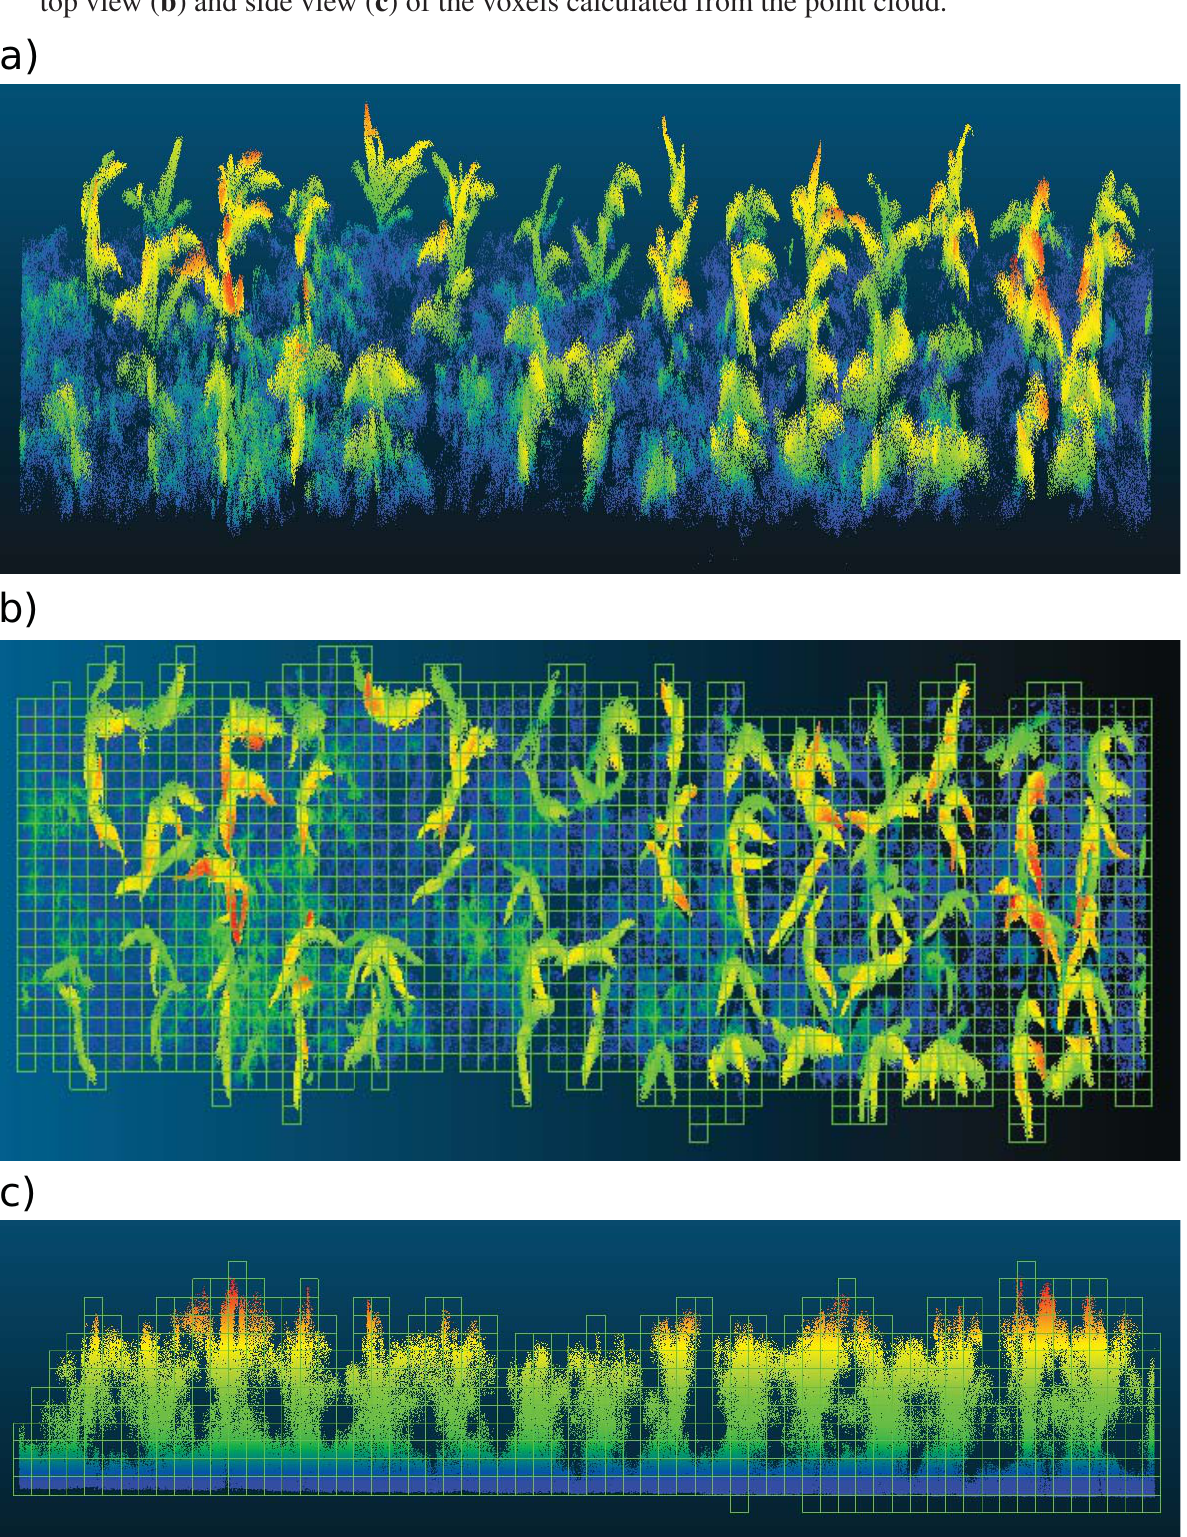
Figure 7. Point cloud calculated from the LiDAR. ( a ) Perspective view of the point cloud; top view ( b ) and side view ( c ) of the voxels calculated from the point